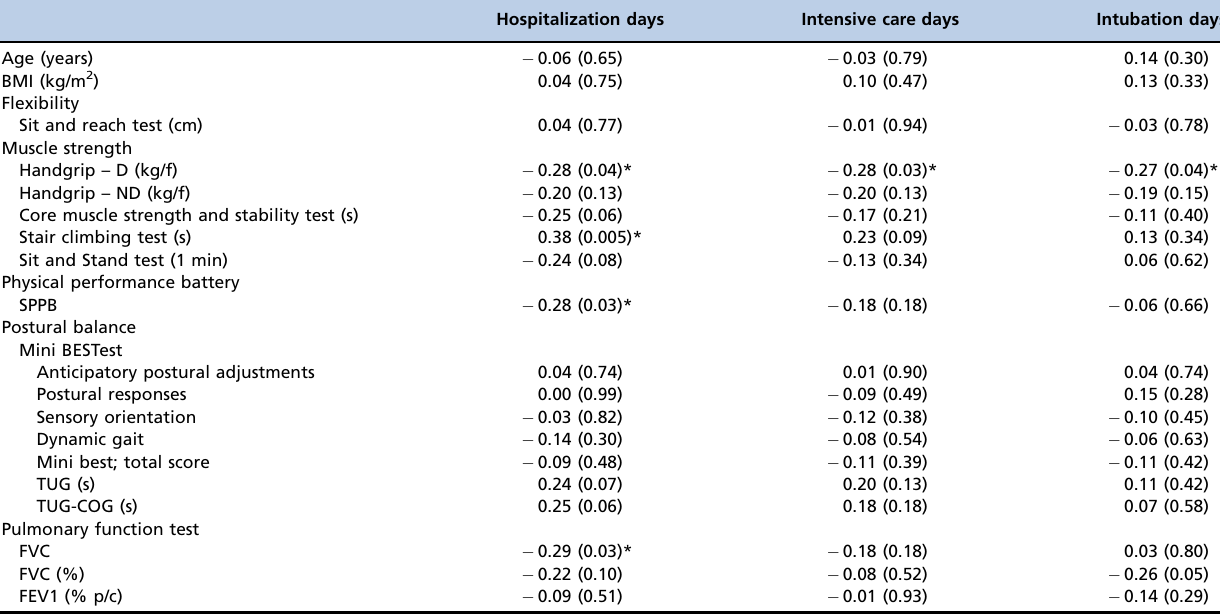
Table 2 - Correlation between hospitalization, intensive care, and intubation days and physical performance/pulmonary